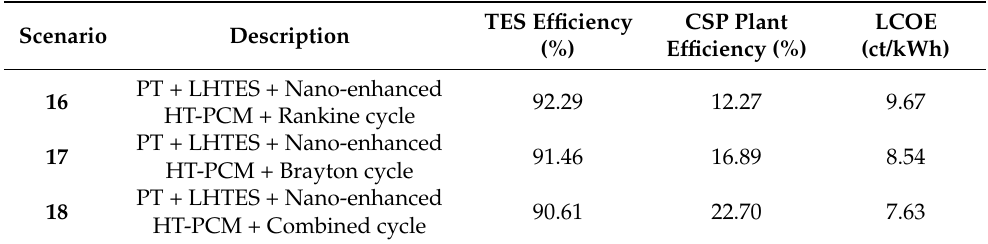
Table 14. LCOE analysis for a solar power tower plant of 100 MW installed capacity with nano- enhanced storage